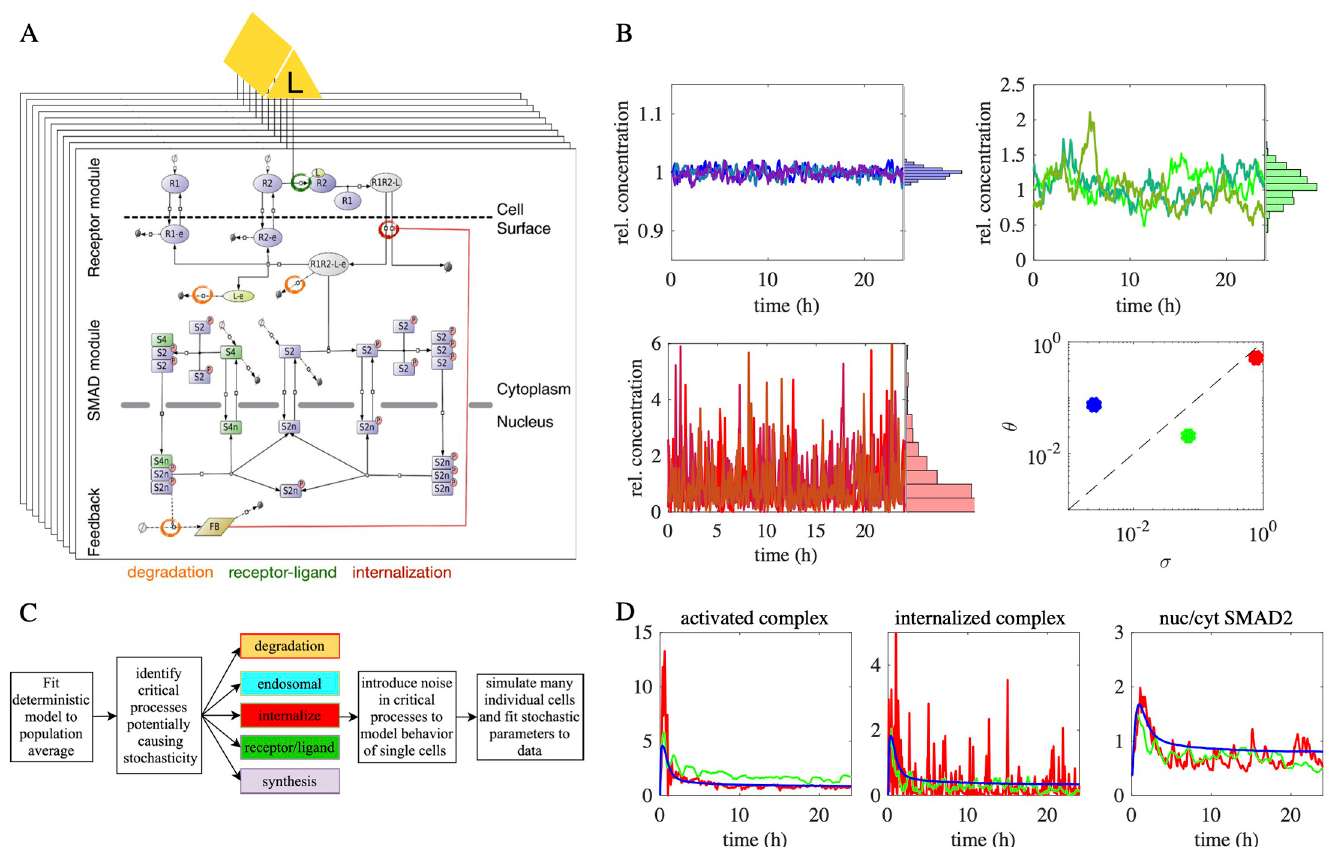
Fig 2. The SMAD-signaling model: From population averages to stochastic single cells. A: Topology of the TGF- β pathway model. Extracellular TGF- β (yellow) binds to free TGF- β receptors on the cell membrane (blue ovals) to form a receptor-ligand complex (gray ovals). This complex is then internalized into the endosome (R1R2Le) and there functions as an enzyme that phosphorylates SMAD2 (blue rectangle). Phosphorylated SMAD forms homo- and heterotrimers, which are transported into the nucleus. Nuclear SMAD further induces the expression of a generic feedback regulator (light green) inhibiting TGF- β receptors. Extensions in the scheme indicate endosomal (e), nuclear (n) and phosphorylated (p) species. State transitions and intercompartmental shuttling are indicated with arrows, enzyme catalysis with circle headed bars, and feedback inhibition with blunt headed bars. Colored circles mark parts of the pathway where stochastic noise was introduced in the ‘degradation’, ‘receptor-ligand’ and ‘internalization’ model variants. This panel was modified from [7]. B: CIR model dynamics for kinetic parameters. Temporal noise in kinetic parameters of the model is shown. For combinations of the variance and reversion parameters σ and θ in the CIR model (3) chosen according to the graph in the bottom right, multiple trajectories are shown, along with their temporal distributions, which resemble log-normal distributions. In the top left, the noise parameter σ was low, whereas it was high otherwise, either with a high (bottom left) or low (top right) reversion parameter θ . C: Flowchart of the modeling approach. Starting from the deterministic model, which was fitted to the population mean, processes within the signaling pathway (colored reaction steps in panel A) were chosen that are sensitive to temporally stochastic occurrences in the cells. Then, random noise (panel B) was introduced in the kinetic parameters connected to the respective critical process (block model). This enabled the reproduction of and model fitting to single cell behavior. D: Propagation of stochastic noise in the model. Noise was introduced in the receptor internalization rates as done in the stochastic internalization model, see S1 Table. The noise controlling parameters of the CIR model were chosen as indicated by the same colors in panel B. Simulated trajectories of the dynamic model concentrations accounting for the activated complex on the cell surface ( y 7 , left), the activated endosomal complex ( y 8 , center) and the nuc/cyt SMAD2 ratio (right) are depicted. For details on model species see S2 Table. The trajectories show how the temporal noise propagates through the pathway for different parameters in the CIR